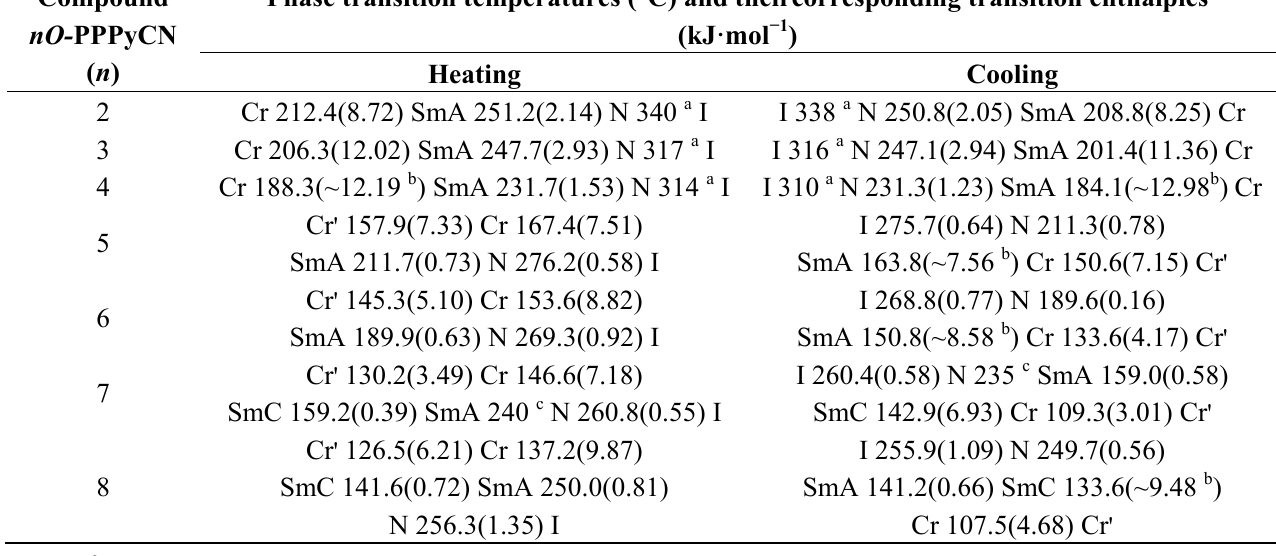
Table 2. Phase transition temperatures (°C) and corresponding transition enthalpies (kJ·mol − 1 ), in parentheses, for homologous series of nO- PPPyCN, n = 2–8.